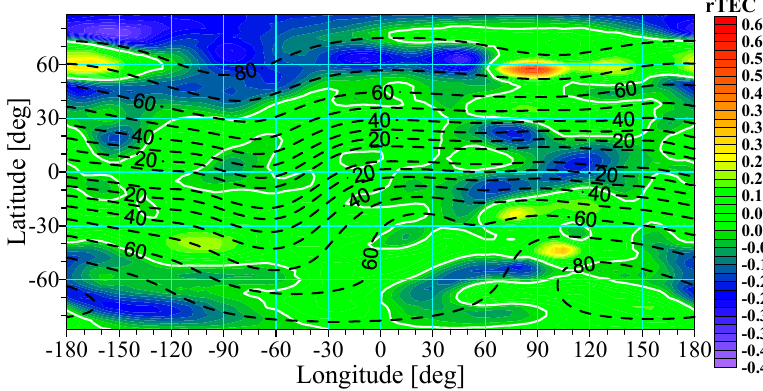
Figure 12. Relative TEC on 3 February 2022 at 16 UTC.